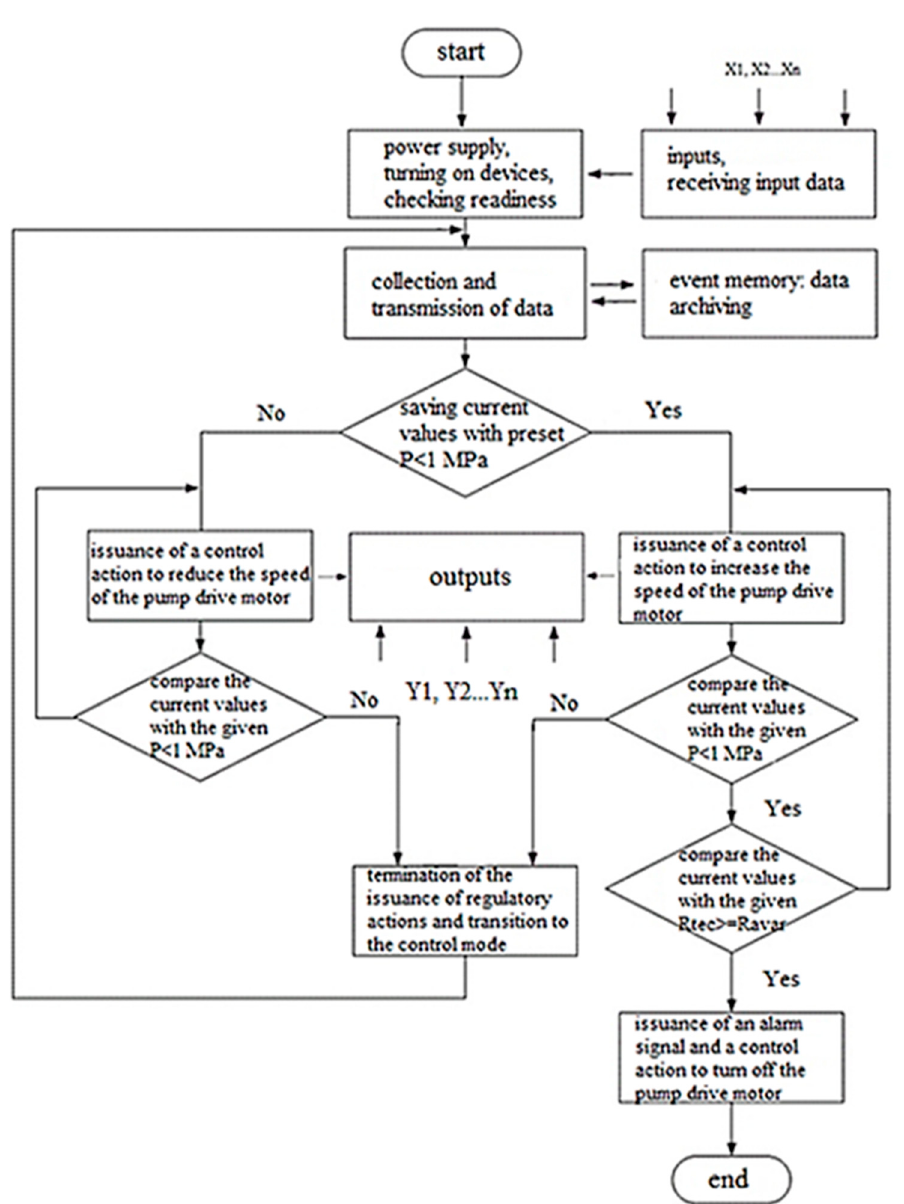
Figure 6. Flowchart of the algorithm for the operation of the laboratory stand on the hydraulic system.